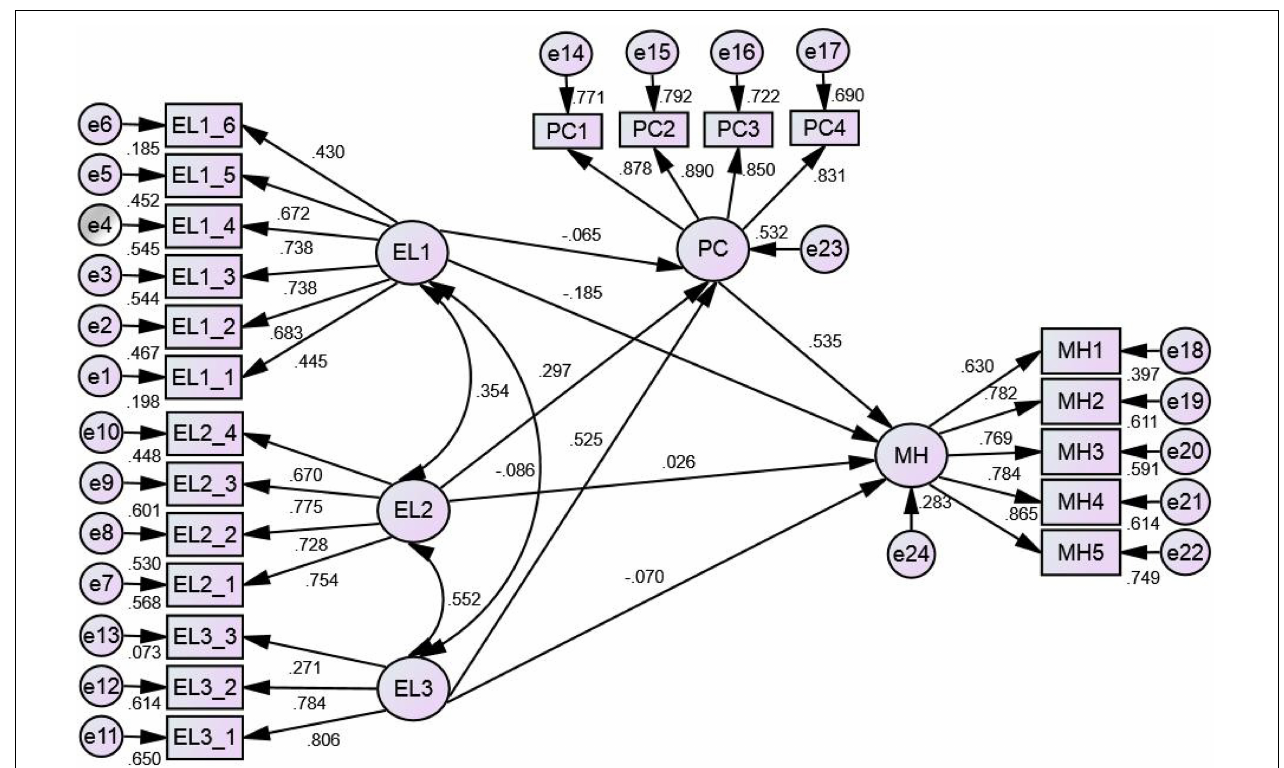
FIGURE 2 | Structural model—Mediational model. EL1, surface acting; EL2, expression of naturally felt emotions; EL3, deep acting; PC, psychological capital; MH, mental